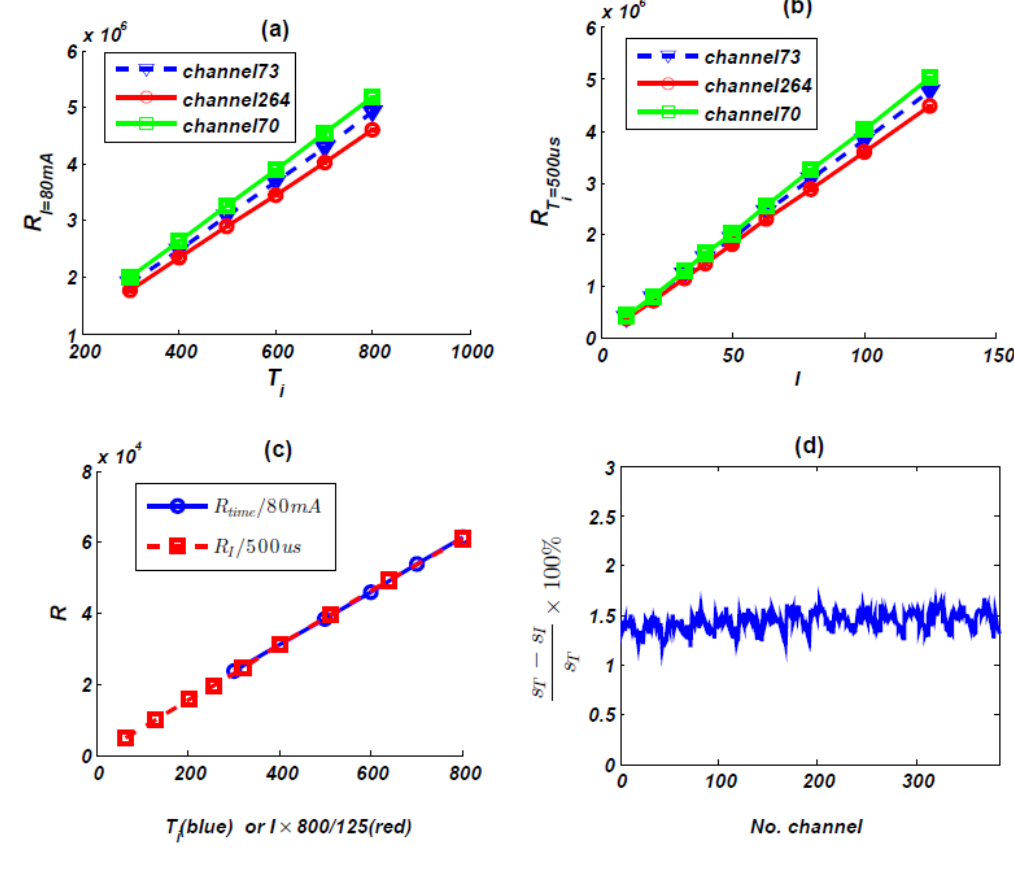
Figure 8. ( a ) Linearity property of R ~ T , X-ray tube parameter is 90 kV, 80 mA; ( b ) Linearity property of R ~ tube